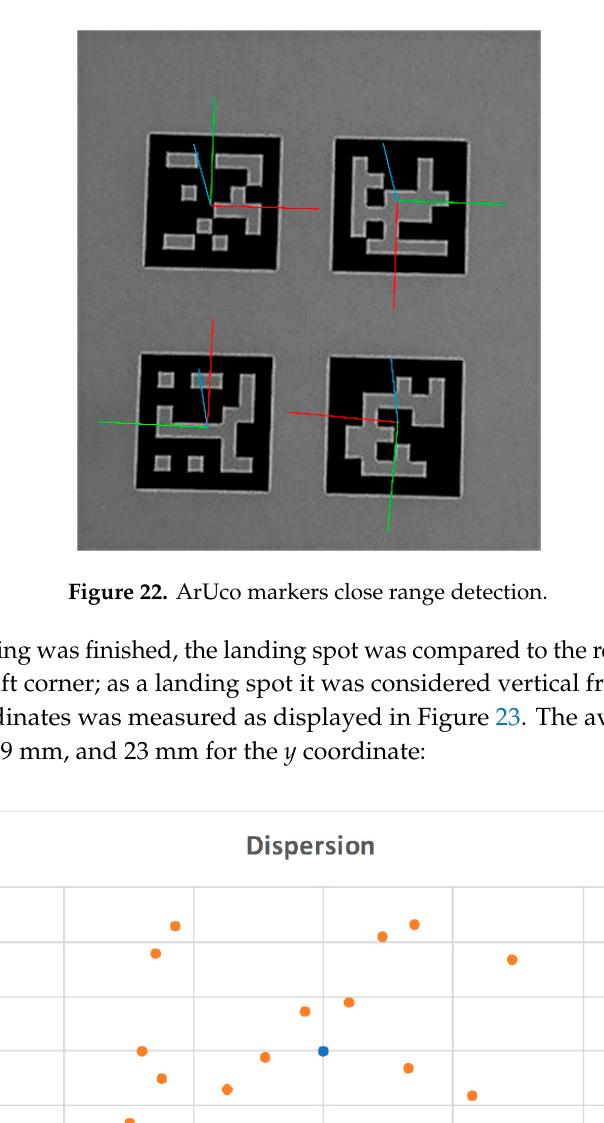
Figure 21. Discrepancy between center coordinates evaluated via circle versus via ArUco markers.